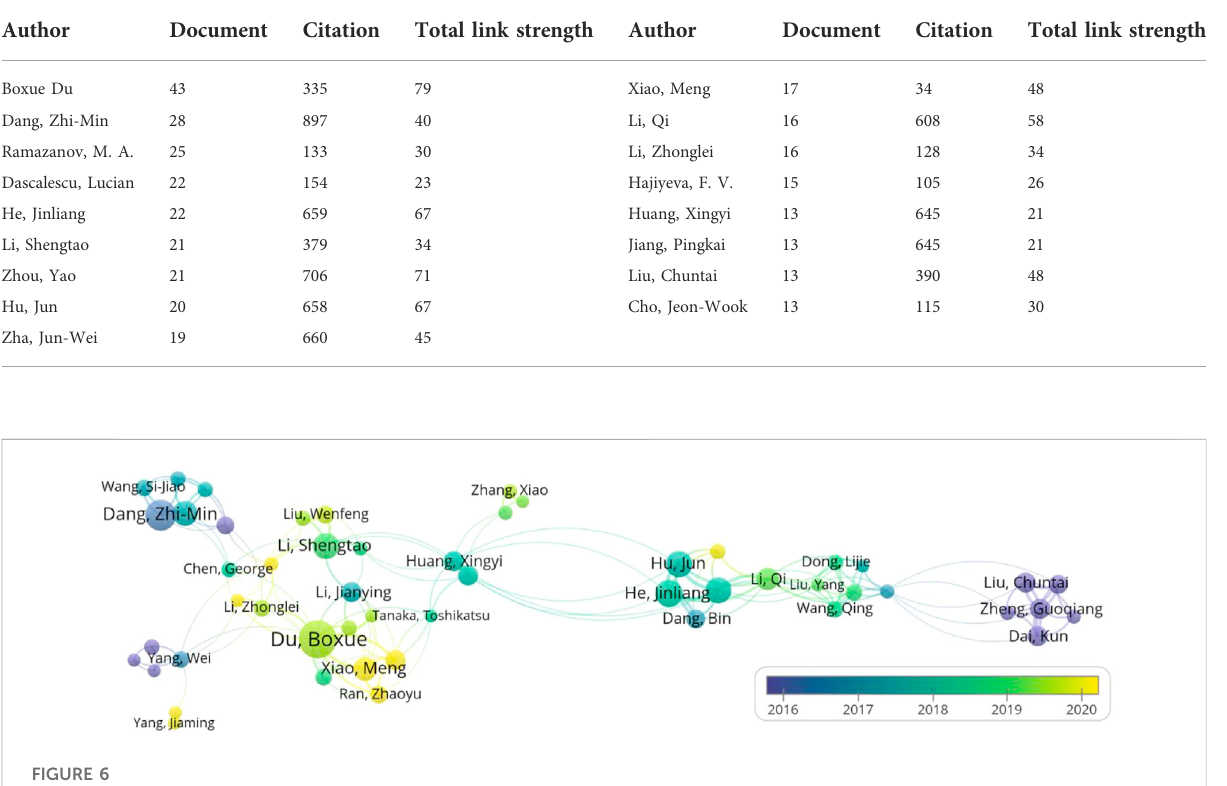
FIGURE 6 Author collaboration network.